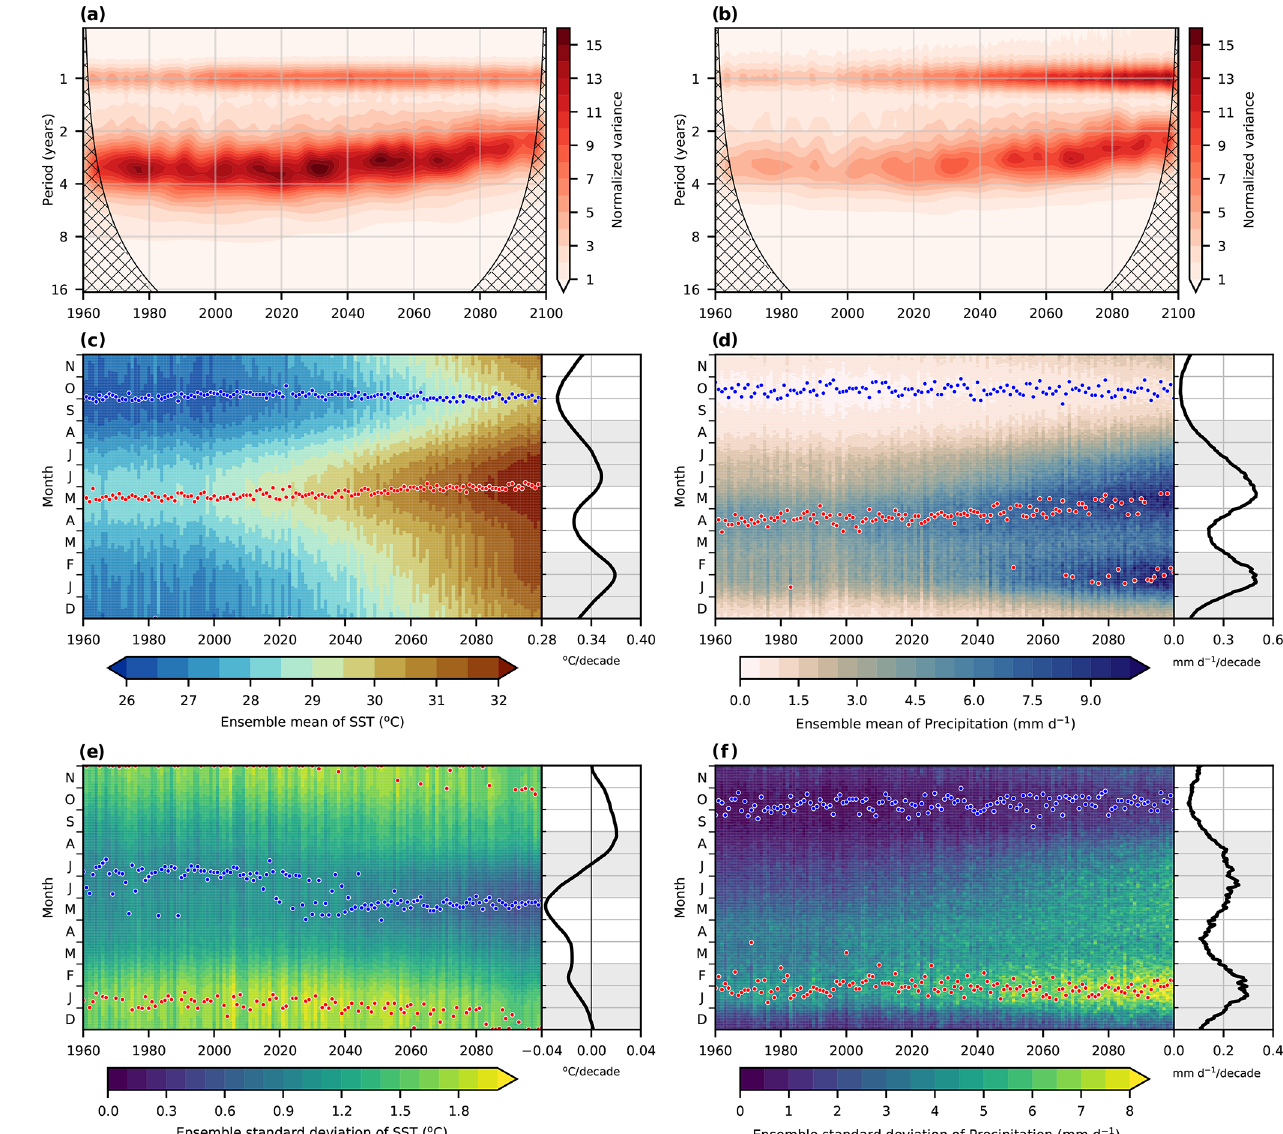
Figure 3. Changes in the dominant frequencies and seasonal variance of sea surface temperature (SST, left) and precipitation (right), in the Niño 3.4 region (5 ◦ S–5 ◦ N, 170 ◦ –120 ◦ W). The top row shows the wavelet power spectra of Niño 3.4 (a) SST and (b) precipitation using a Morlet wavelet, normalized by σ − 2 , where σ is the ensemble mean standard deviation of the respective Niño 3.4 time series (Torrence and Compo, 1998). The y axis shows the equivalent Fourier period in years. The hatching indicates regions where the wavelet spectrum is not trustworthy due to edge effects. Prior to calculating the wavelet spectra, the time series were detrended by subtracting the ensemble-mean annual means, which were linearly interpolated to a monthly time step. The middle row shows the ensemble-mean of Niño 3.4 (c) SST and (d) precipitation indicated for each day (ordinate) and year (abscissa) using daily output. The red (blue) dots indicate the maximum (minimum) daily values of each year. The black line to the right in panels (c–f) indicates the linear trend over 1960–2100. The bottom row shows the same as for (c) and (d) , but for the across-ensemble SDs of (e) SST and (f)